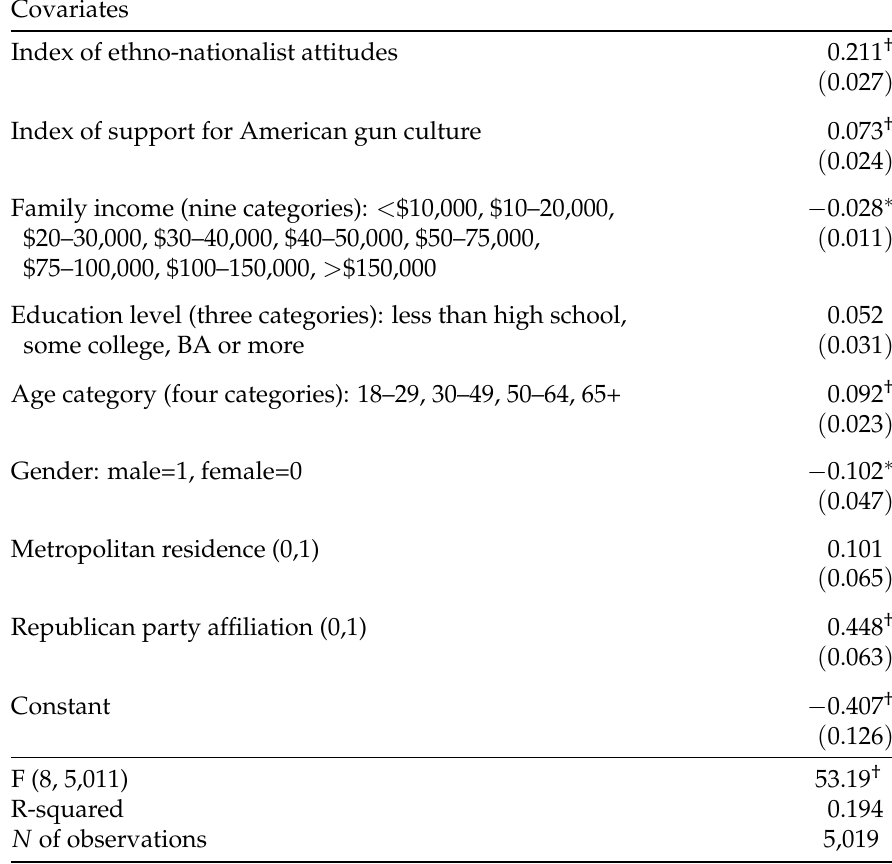
Table 1: Regression estimates of the effect of ethno-nationalist sentiment on anti- immigrant